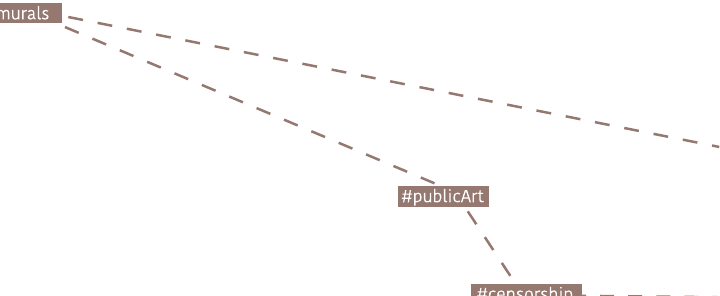
Figure 11: Jenny Roesel Ustick, Warrior, 2019. Limited edition screen print, 66 x 50.8 cm. This depiction of Columbia is derived from the Boston Massacre monument at Boston Common, also referred to as the Crispus Attucks monument cast and dedicated post-reconstruction, in